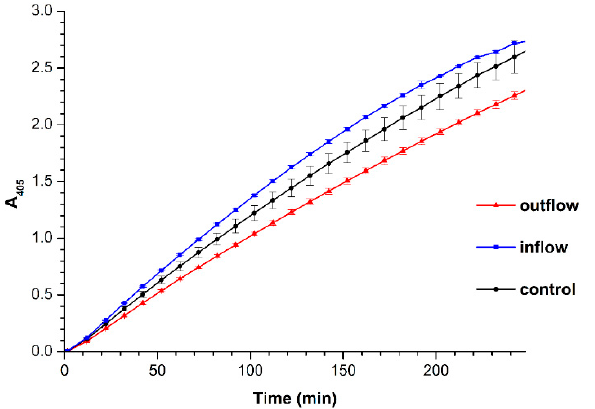
Figure 4. Spectrophotometry-based estimation of HRP enzymatic activity. Characteristic time dependencies of change in solution absorbance at 405 nm obtained for control HRP sample and for HRP samples incubated in the experimental setup. The measuring cell (containing HRP solution) was placed either far away at a 10-m distance from the experimental setup (control experiment, black line), near the inflow (blue line) or near the outflow (red line) section of the pipe. Experimental conditions: HRP:ABTS:H 2 O 2 = 10 − 9 M:3 mM:2.5 mM. T = 23 °C.